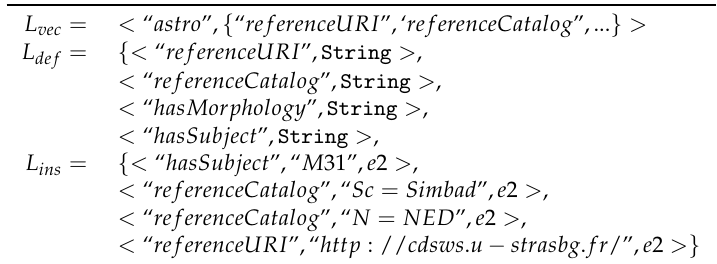
Table 4. Label definitions and a snapshot of the label space for w